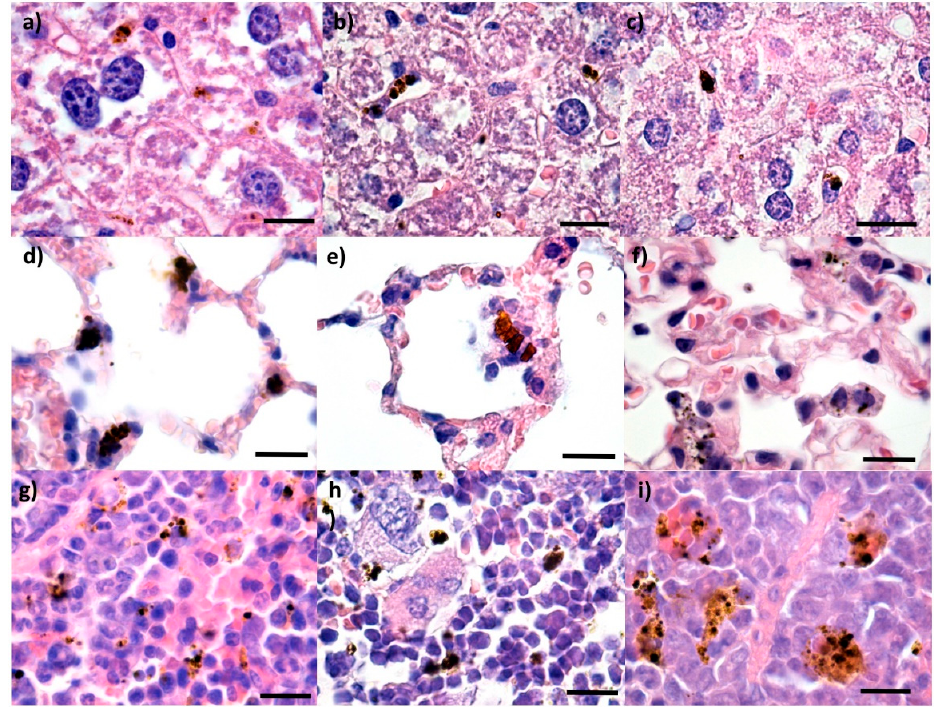
Figure 6. Cross-section through the ( a – c ) liver, ( d – f ) lungs, and ( g – i ) spleen from mice injected with Fe 3 O 4 ( a , d , g ), Fe 3 O 4 @PEG 20 K ( b , e , h ) and Fe 3 O 4 @PEG 35 K NPs ( c , f , i ), respectively, and harvested at 2 days after intravenous administration; normal morphology; Hematoxylin–Eosin staining; 1000× magnification, scale bar 25 μ m.